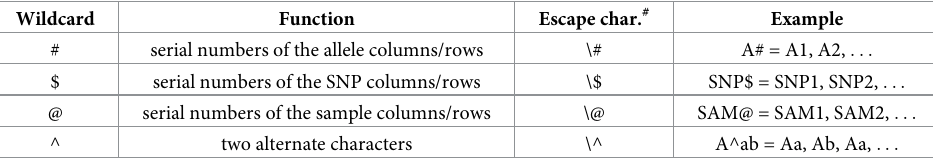
# 6 combinations of genetic models and phenotypes (Logited and non-logited). ## includes Slider and SeattleSNPs versions. ### includes letter order and major counting